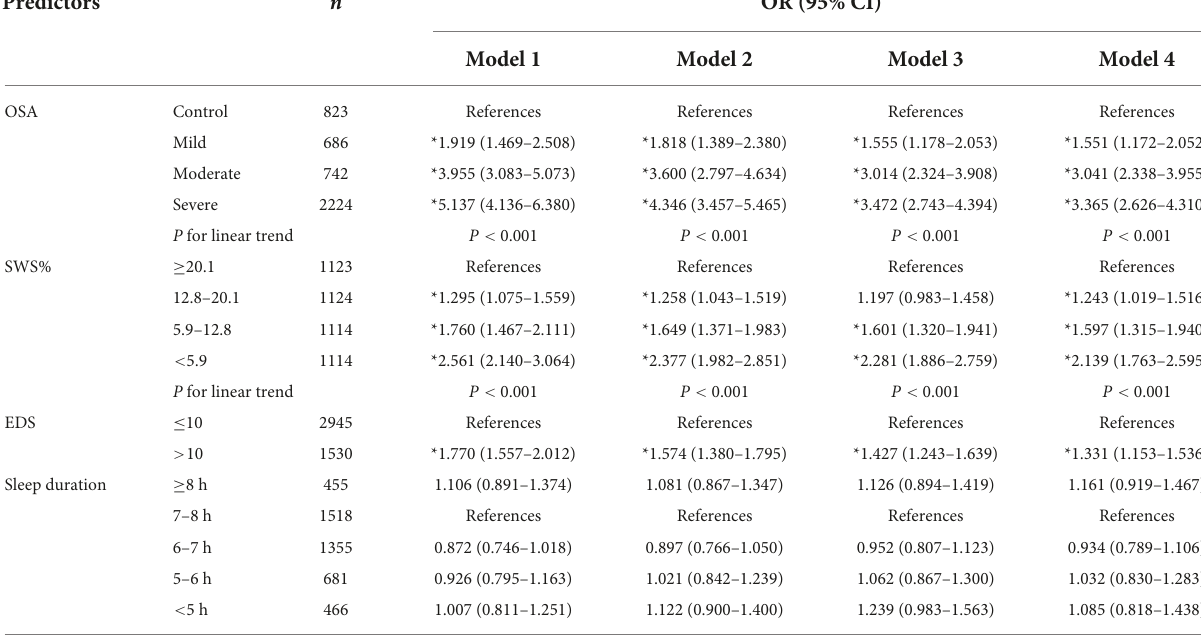
TABLE 3 Association of OSA, SWS, EDS, SSD and the moderate-to-high Framingham CVD risk in the whole cohort.